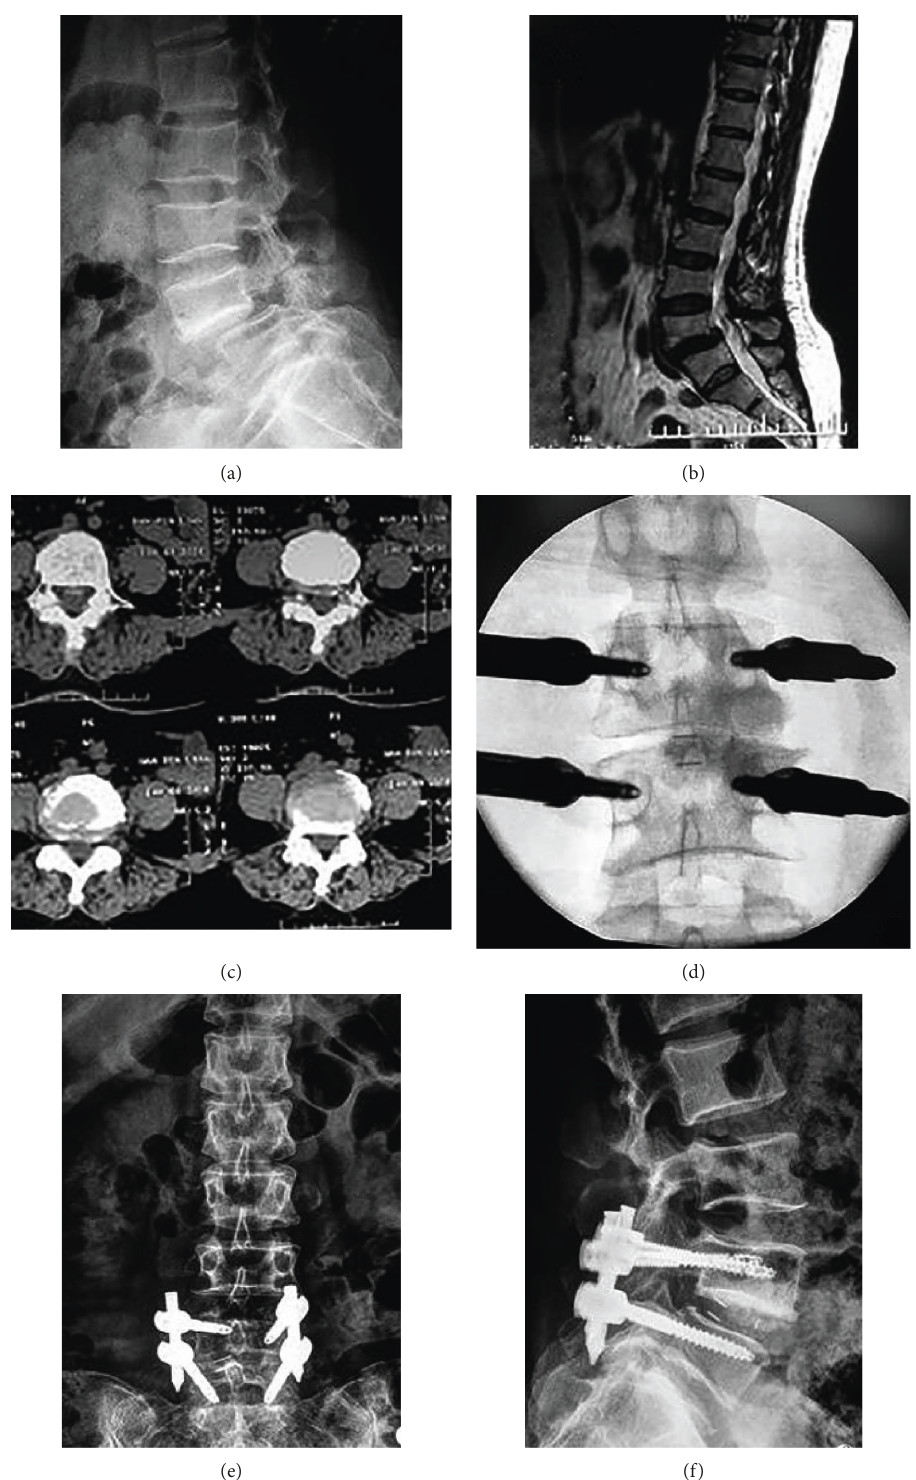
Figure 3: (a) 56-year-old female patient with lumbar spondylolisthesis. The clinical signs are mainly lumbar pain and intermittent claudication. (a, b) and (c) are the X-ray, MRI, and CT data of the patient before the operation. The patient is diagnosed as L4 spon- dylolisthesis II. (d) is the data of the patient’s percutaneous pedicle screw surgery during the operation. (e and f) are the results of the patient’s 1 week postoperative review. It can be seen that the patient’s lumbar spondylolisthesis has been effectively corrected and the internal fixation is